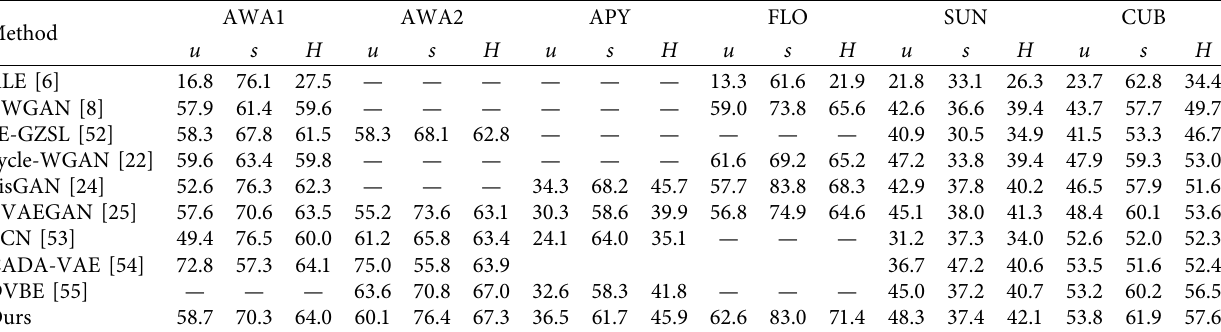
Table 3: Results of GZSL on six classification benchmarks respectively. GZSL measuring the harmonic mean H of the per-class top-1 accuracy u on c u and the per-class top-1 accuracy s on c u . The “—” means that there are no relevant results in the reference, while the underlined results are reproduced according to the description of references.